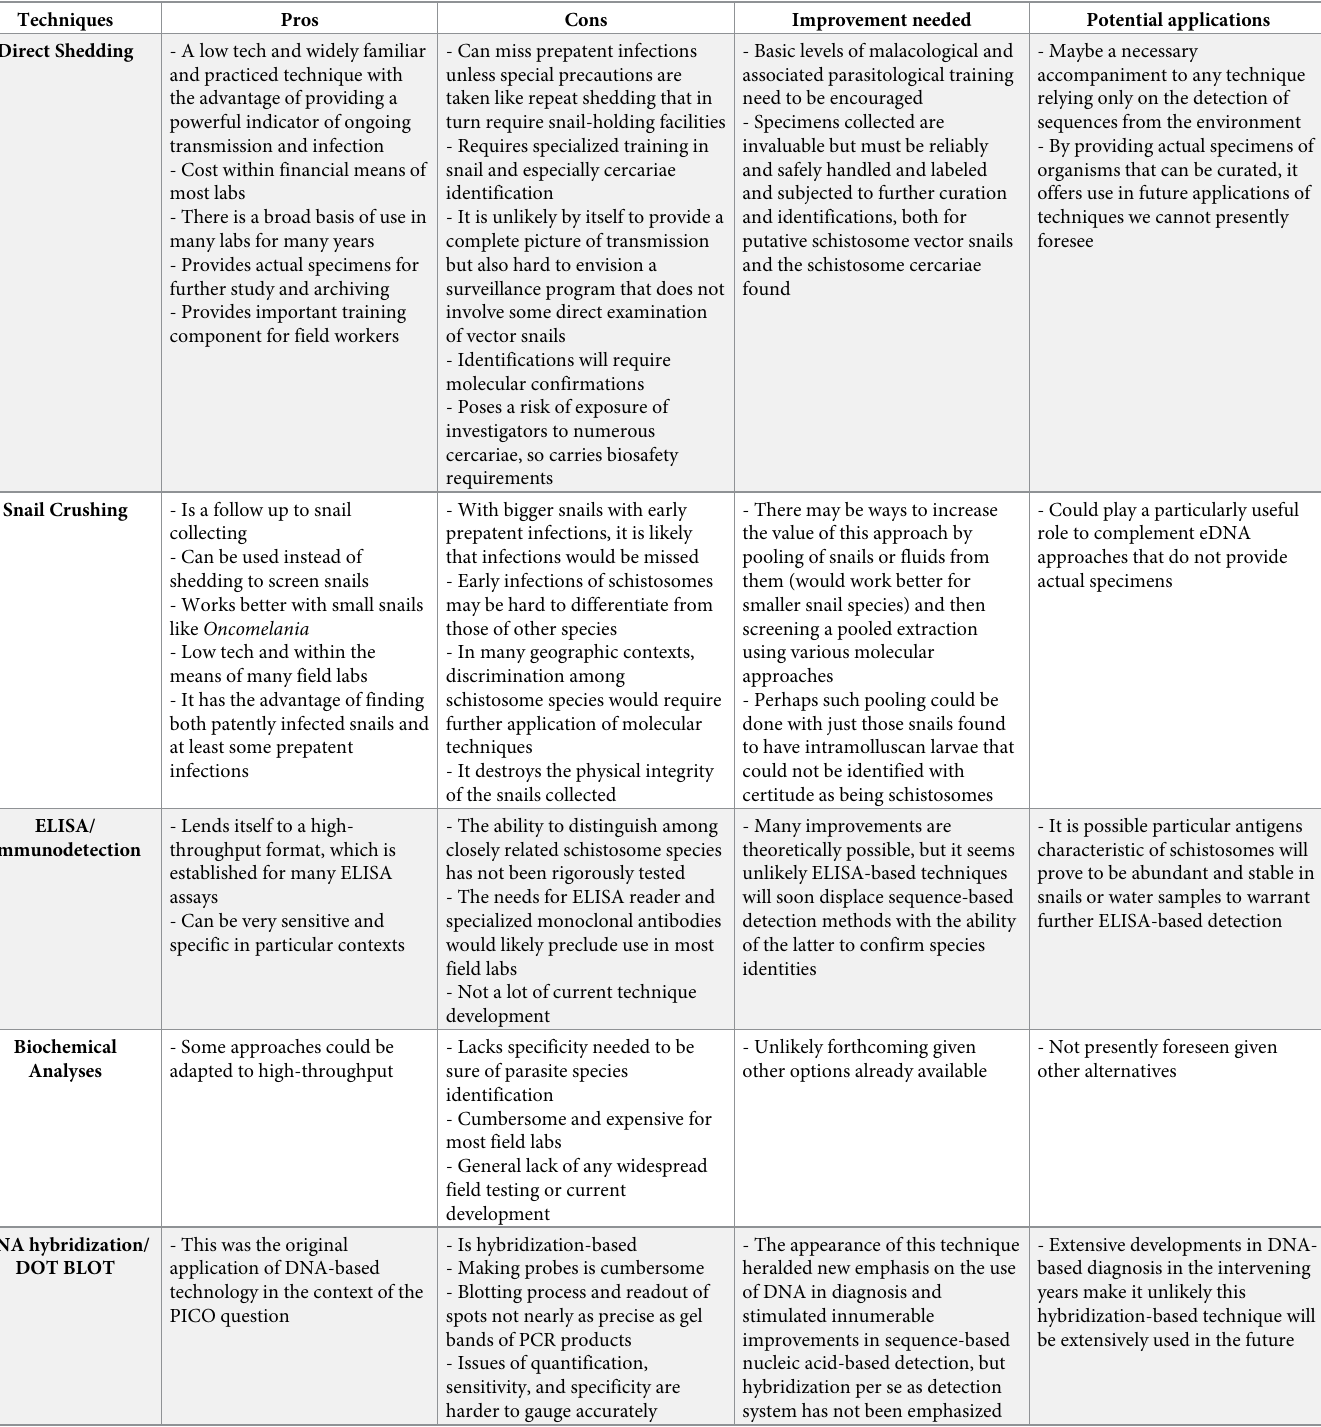
Table 3. A summary of perceived advantages and disadvantages of the techniques evaluated, with comments on possible improvements and potential applications.